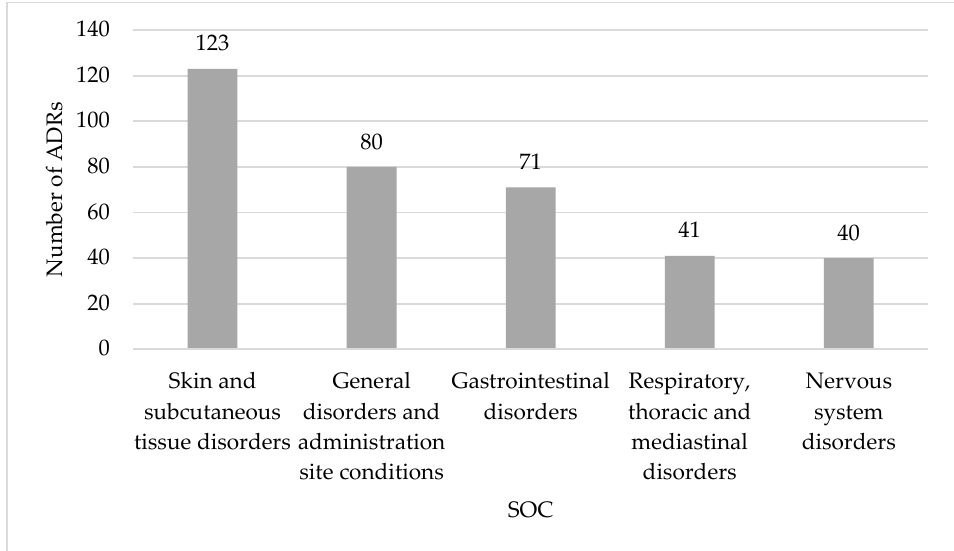
10 of 18 Figure 1. Single non-steroidal anti-inflammatory drugs (NSAIDs) involved in suspected adverse drug reaction (ADR) reports spontaneously reported to the Portuguese Pharmacovigilance System from 2008 to 2018 for people aged 65 years or older: the top five. The mostly reported NSAIDs as a single suspected drug associated to ADRs were diclofenac (39 reports) followed by etoricoxib (27 reports). In 180 reports (69.0%) only one NSAID was referred as the suspected drug, but in 71 reports (27.2%) a NSAID was associated to other drug classes, and in 10 reports (3.8%) associations between NSAIDs were detected. Most suspected ADRs occurred in females